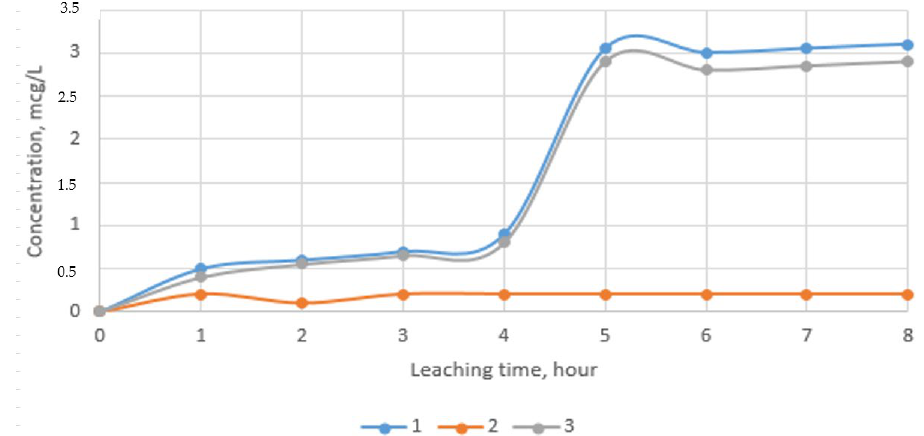
Figure 14. Kinetics of Zn 2+ extraction from bricks in various media.